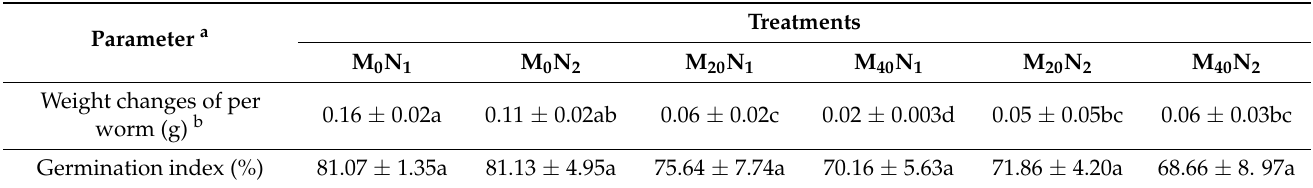
Table 2. Biological parameters of weight changes of earthworms and germination index.